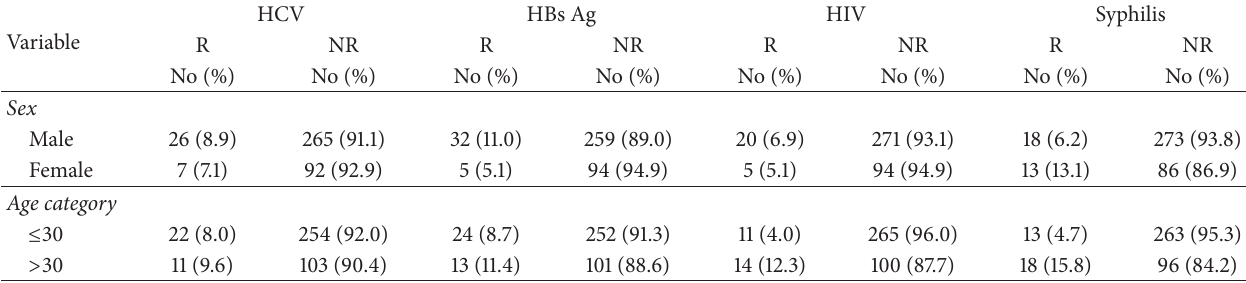
Table 1: Distribution of blood borne pathogens by sex and age among blood donors at Wolaita Sodo Teaching Referral Hospital, 2015.